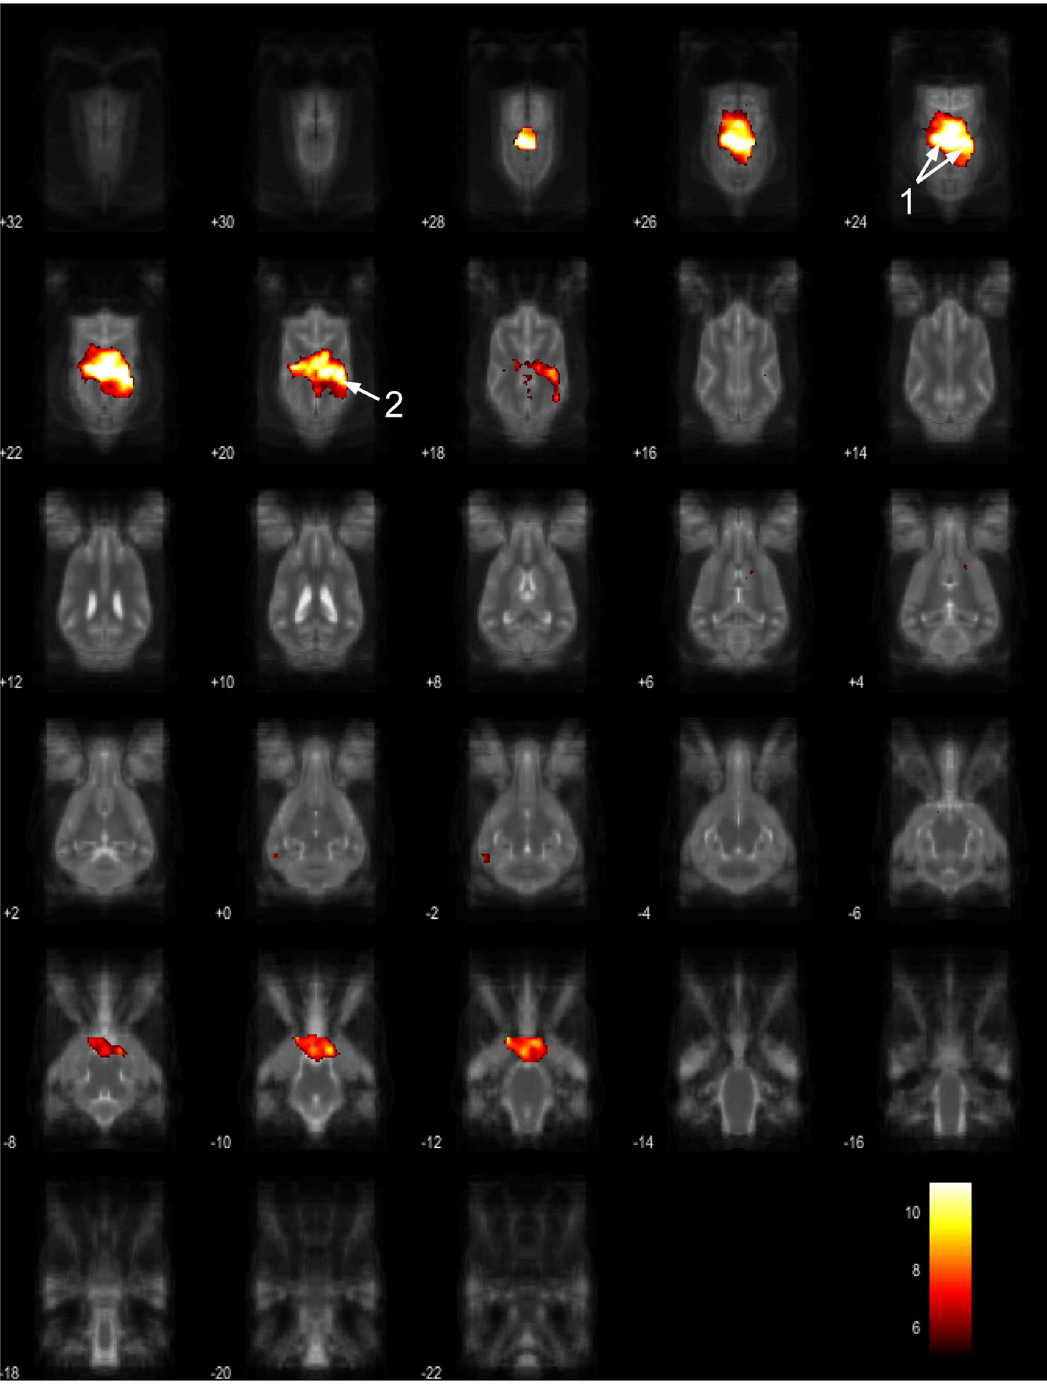
component fused with L, the other visual component), and O. These nonmatching components usually were some